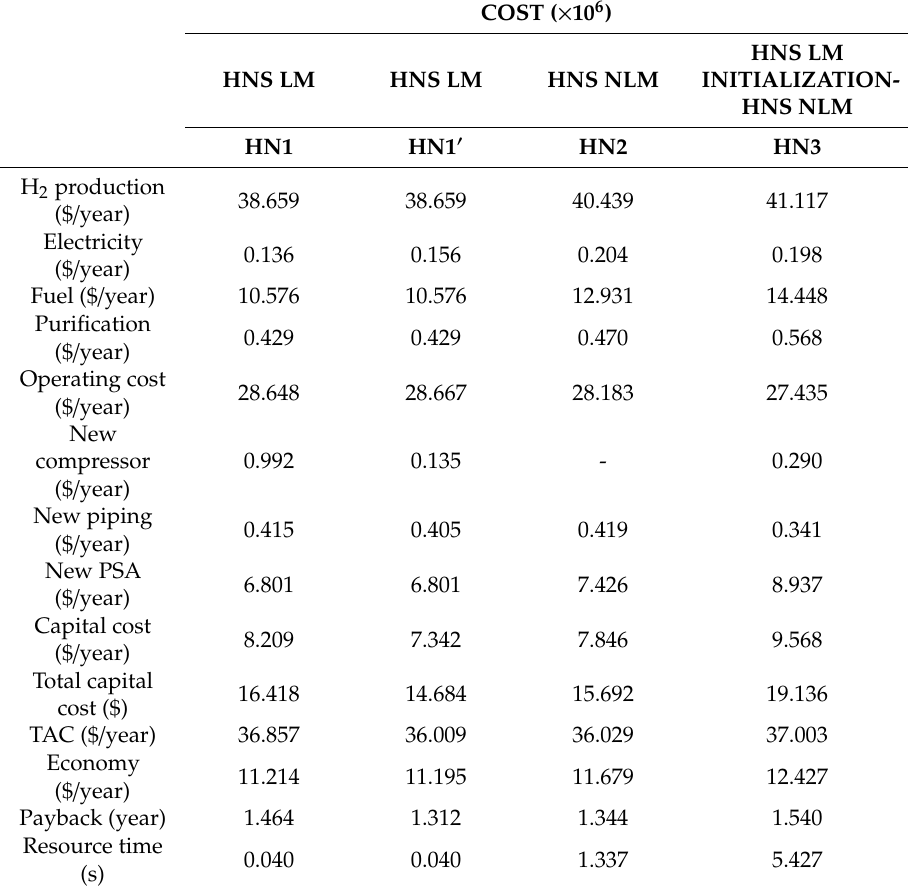
Table 4. Results obtained in the di ff erent optimizations models for example